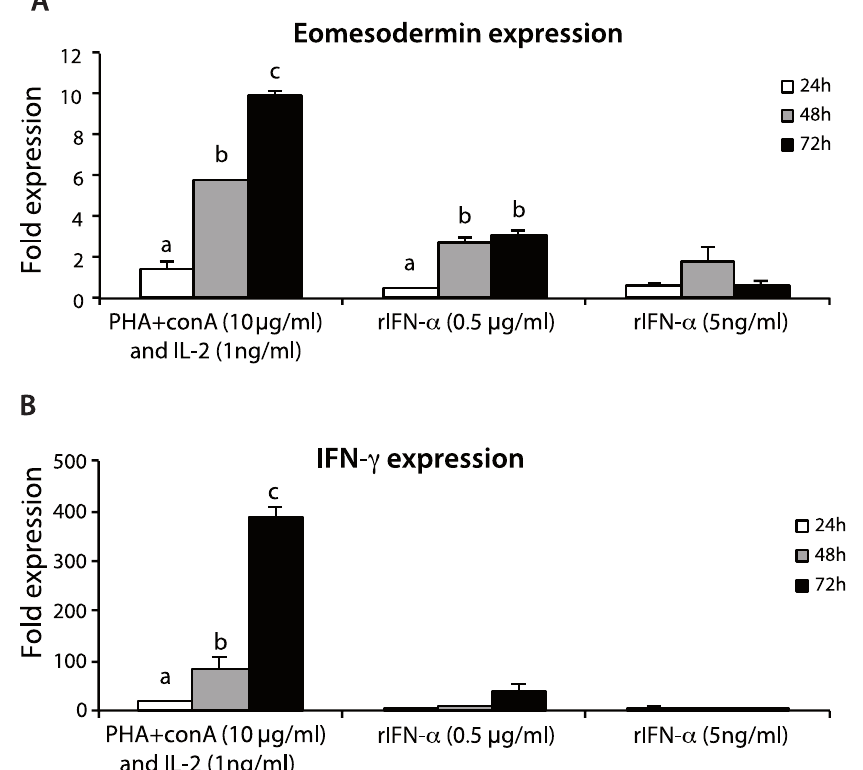
Figure 6. Regulators of Eomes expression in salmon lymphocytes. Spleen leukocytes were stimulated for 24 h, 48 h, and 72 h with ConA + PHA + huIL-2, IFN- a (0.5 m g/ml, and 5 ng/ml), and the mRNA levels of Eomes (A), and IFN- c (B) were determined by real-time PCR. Gene expression is normalized against EF-1 a and is shown relative to the mean of the non-stimulated cells. Each bar represents the mean 6 SE of triplicate samples. Different letters denote statistically significant differences between the